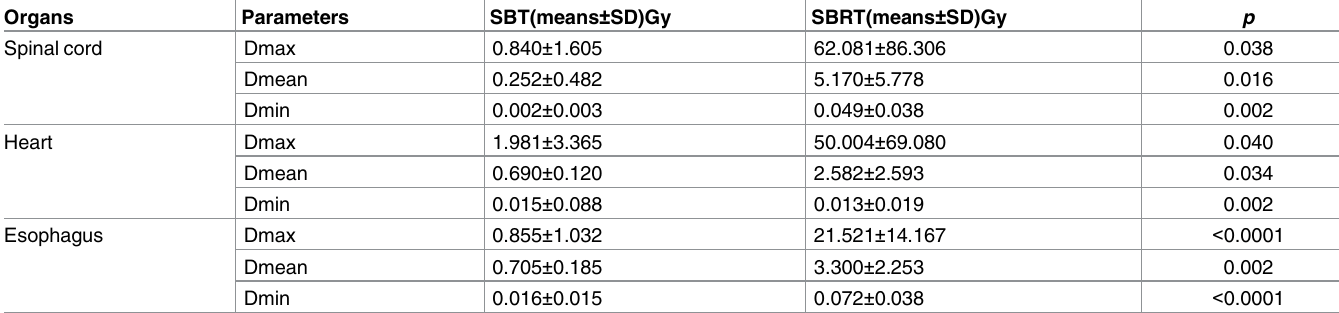
Table 4. Dosimetric comparison of the OARs between SBT and SBRT after radiobiological conversion.